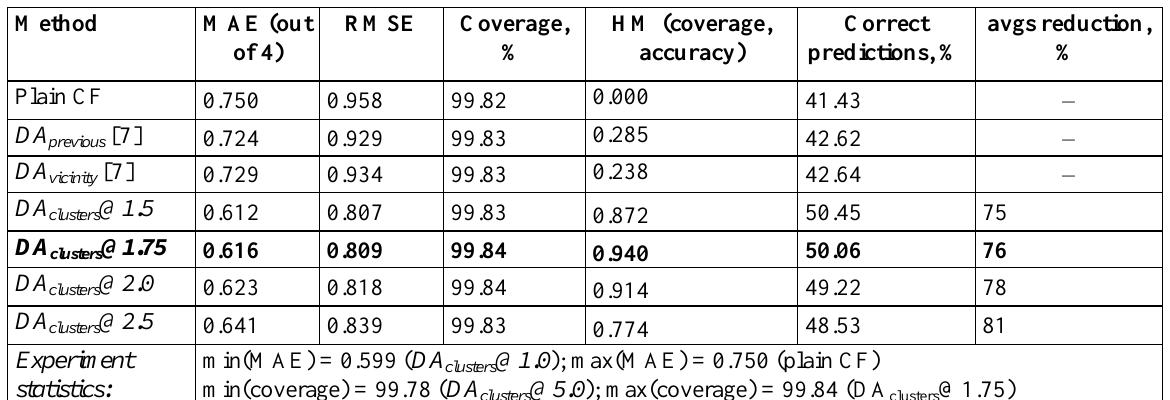
Table 6. MovieLens “Old 100K” dataset results